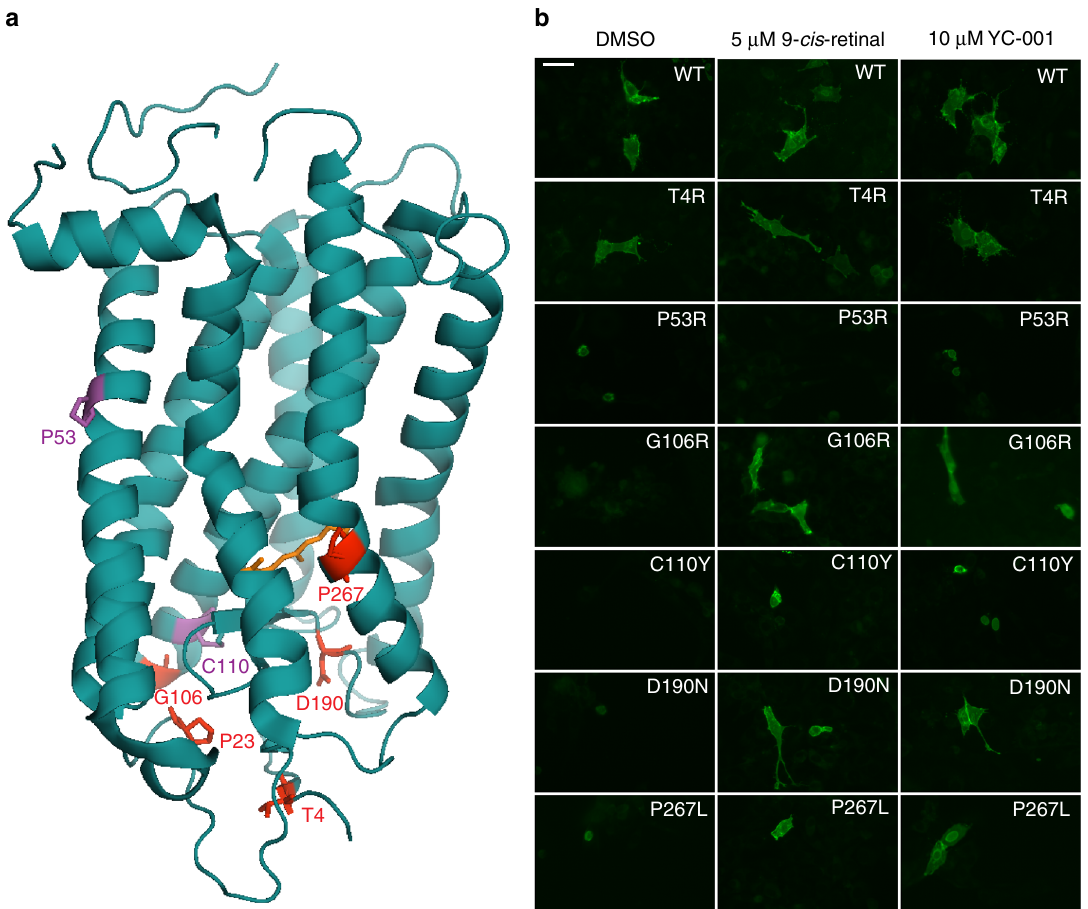
Fig. 8 Effect of YC-001 on the transport of rod opsin mutants. a Illustration of seven autosomal dominant retinitis pigmentosa associated mutation sites on the bovine rhodopsin crystal structure (PDB ID: 1f88). The overall structure of rhodopsin is shown in blue with 11- cis -retinal labeled in orange. Side chains of T4, P23, G106, D190, and P267 are labeled in red, and side chains of P53 and C110 are labeled in magenta. b Cell-surface immunostained images of rod opsin mutants expressed in NIH3T3 cells exposed to DMSO, 9- cis -retinal or YC-001. Cells transfected with human rhodopsin WT or mutants were treated with DMSO (0.1%) or YC-001 (10 µ M) for 24 h. Cells were fi xed and only rod opsin on the cell surface was immunostained with Alexa 488-conjugated B6- 30 anti-rhodopsin antibody. Green fl uorescence images were taken under a ×20 objective. 9- cis -retinal was tested at 5 μ M and YC-001 at 10 μ M, as labeled in each panel. This experiment was repeated